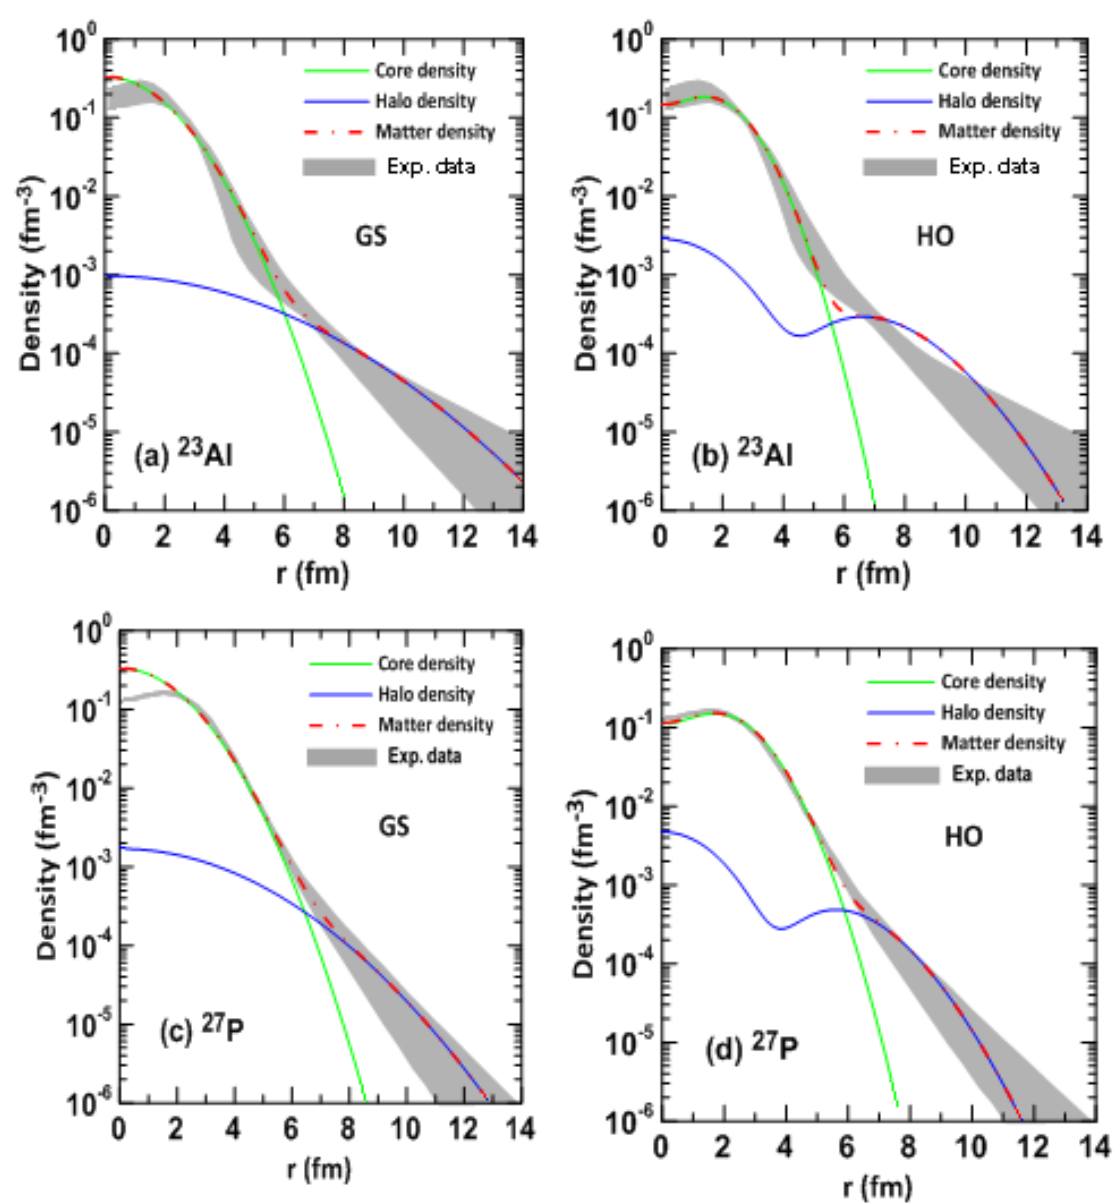
Fig. 2: The core, halo and matter density distributions for halo nuclei 23 Al and 27